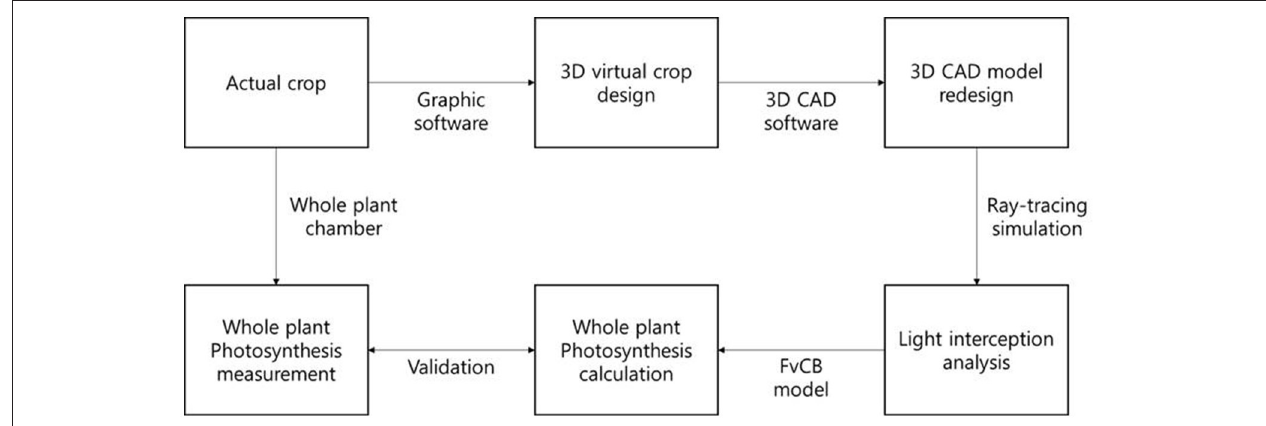
FIGURE 4 | A work flow for construction of 3D plant model, calculation, and validation of a whole plant photosynthesis rate.